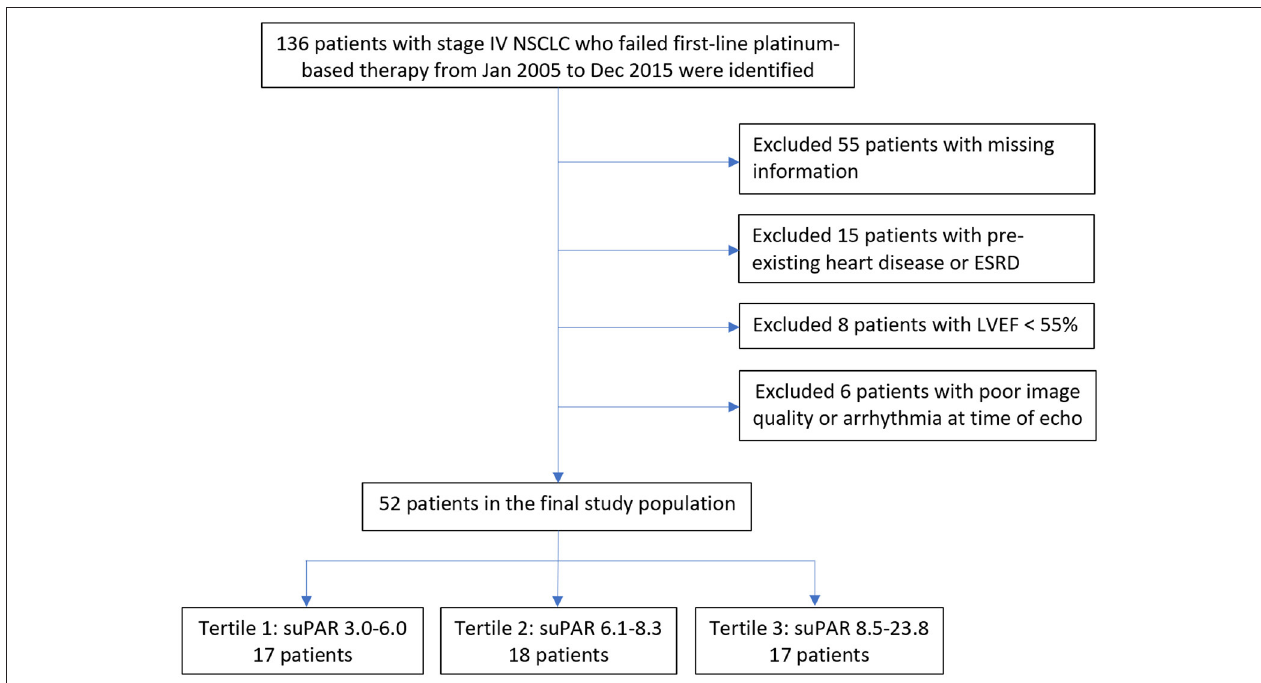
FIGURE 1 | Study population flowchart. Displays the initial study population through the final study population, exclusions included. ESRD, End Stage Renal Disease; LVEF, Left Ventricular Ejection Fraction; NSCLC, Non-Small Cell Lung Cancer; suPAR, soluble urokinase-type Plasminogen Activator